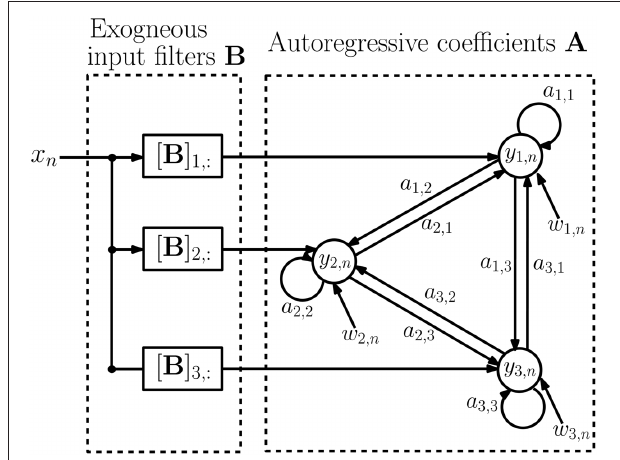
FIGURE 3 | Schematic diagram of the MVARX model. y i , n denotes the recorded signals at the electrodes while x n represents current stimulation and w i , n is model error, or equivalently, a random input that generates spontaneous activity. a i , j captures the a priori unknown connectivity between recording sites while [ B ] i , : represents the a priori unknown transmission characteristics between the stimulus and recording